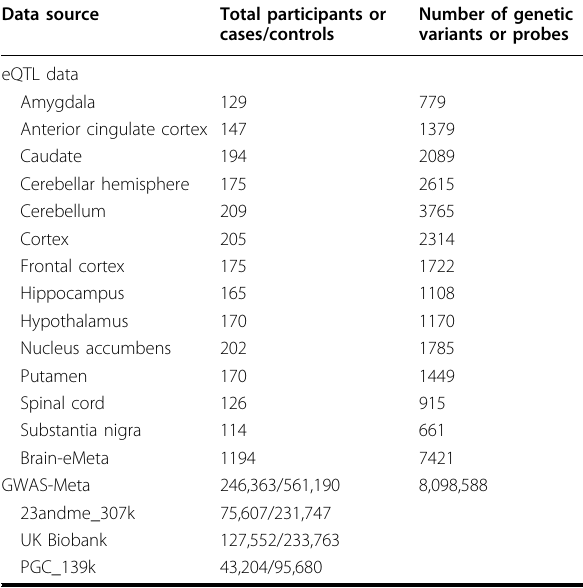
Table 1 Basic information of the eQTL and GWAS